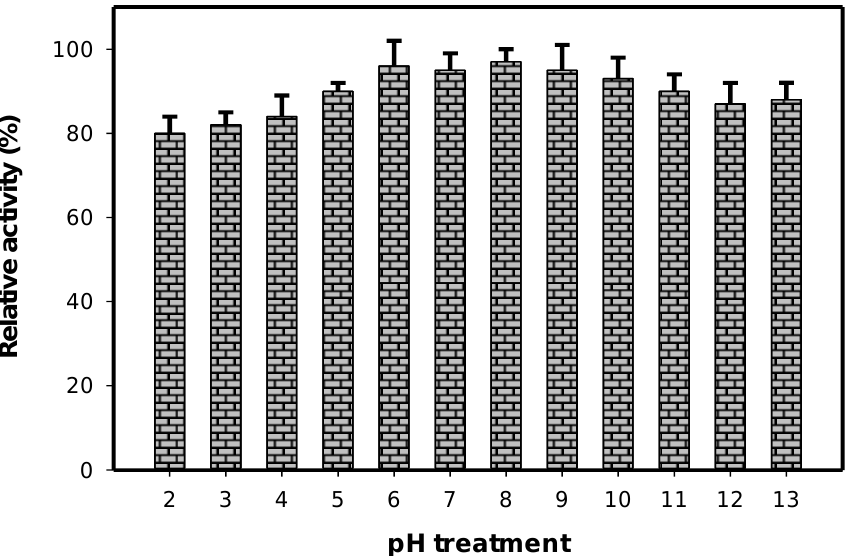
Figure 2. The pH stability of HDT. The sample was treated in the range of pH 2 – 13 at 37 °C for 30 min. The α -glucosidase inhibitory activity was then tested and expressed as relative activity (%). Yeast α -glucosidase was used for the enzymatic inhibition assay. Results are means ± SD of multi tests (n = 3).